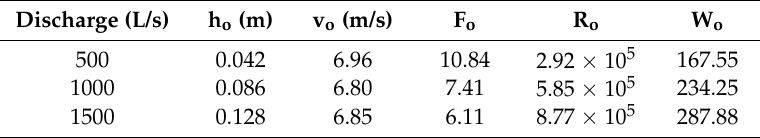
Table 1. Hydraulic conditions and dimensionless